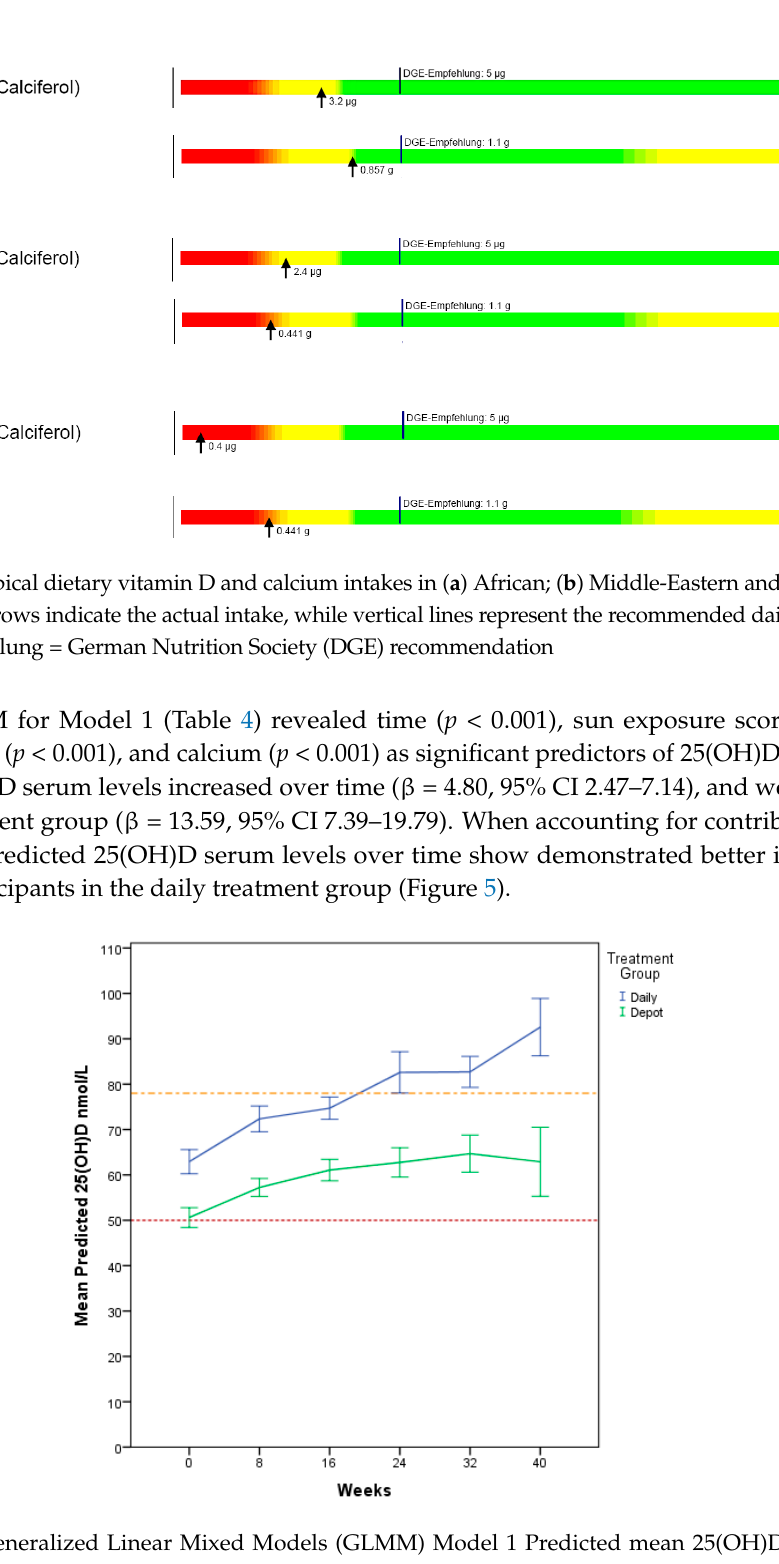
Figure 5. Generalized Linear Mixed Models (GLMM) Model 1 Predicted mean 25(OH)D nmol/L change over time; -- 50 nmol/L threshold -- . 78 nmol/L threshold.